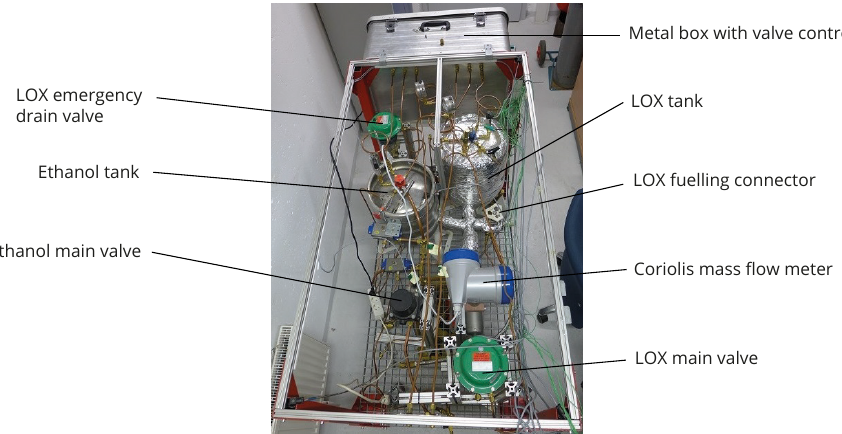
Figure 4. Test rig for the experimental examination of chemical space propulsion systems with the propellants ethanol (left fluid line) and LOX (right fluid